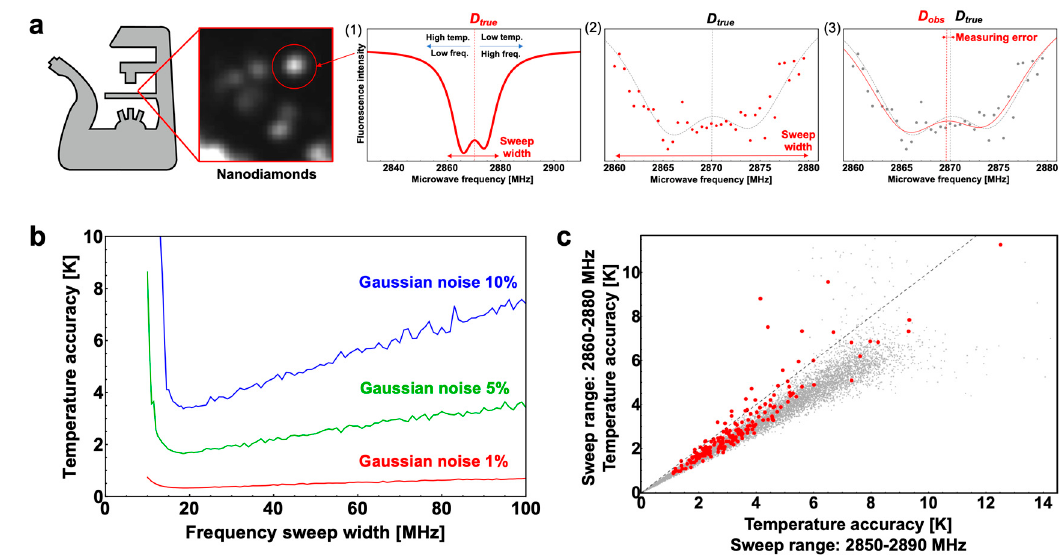
Figure 1. Monte Carlo simulation to determine the optimal sweep range for optically detected magnetic resonance (ODMR) frequency spectrum for temperature determination. ( a ) Schematic outline of temperature determination by ODMR. In the simulation, the ODMR frequency spectrum obtained by a digital frequency sweep during the fluorescence intensity measurements, as shown in (2), was generated at random. ( b ) Simulated temperature measurement accuracy of the frequency sweep width centered at 2870 MHz. The results applied Gaussian noises at 10%, 5%, and 1% of the ODMR signal intensity are shown. ( c ) Comparison of the temperature determination accuracies obtained by the simulation between the sweep ranges of 2850–2890 MHz and 2860–2890 MHz. The red line indicates where the accuracy of the two temperature determinations was equal. Comparison of the temperature determination accuracies obtained through the ODMR measurements between the sweep ranges of 2850–2890 MHz and 2860–2890 MHz were also plotted (red